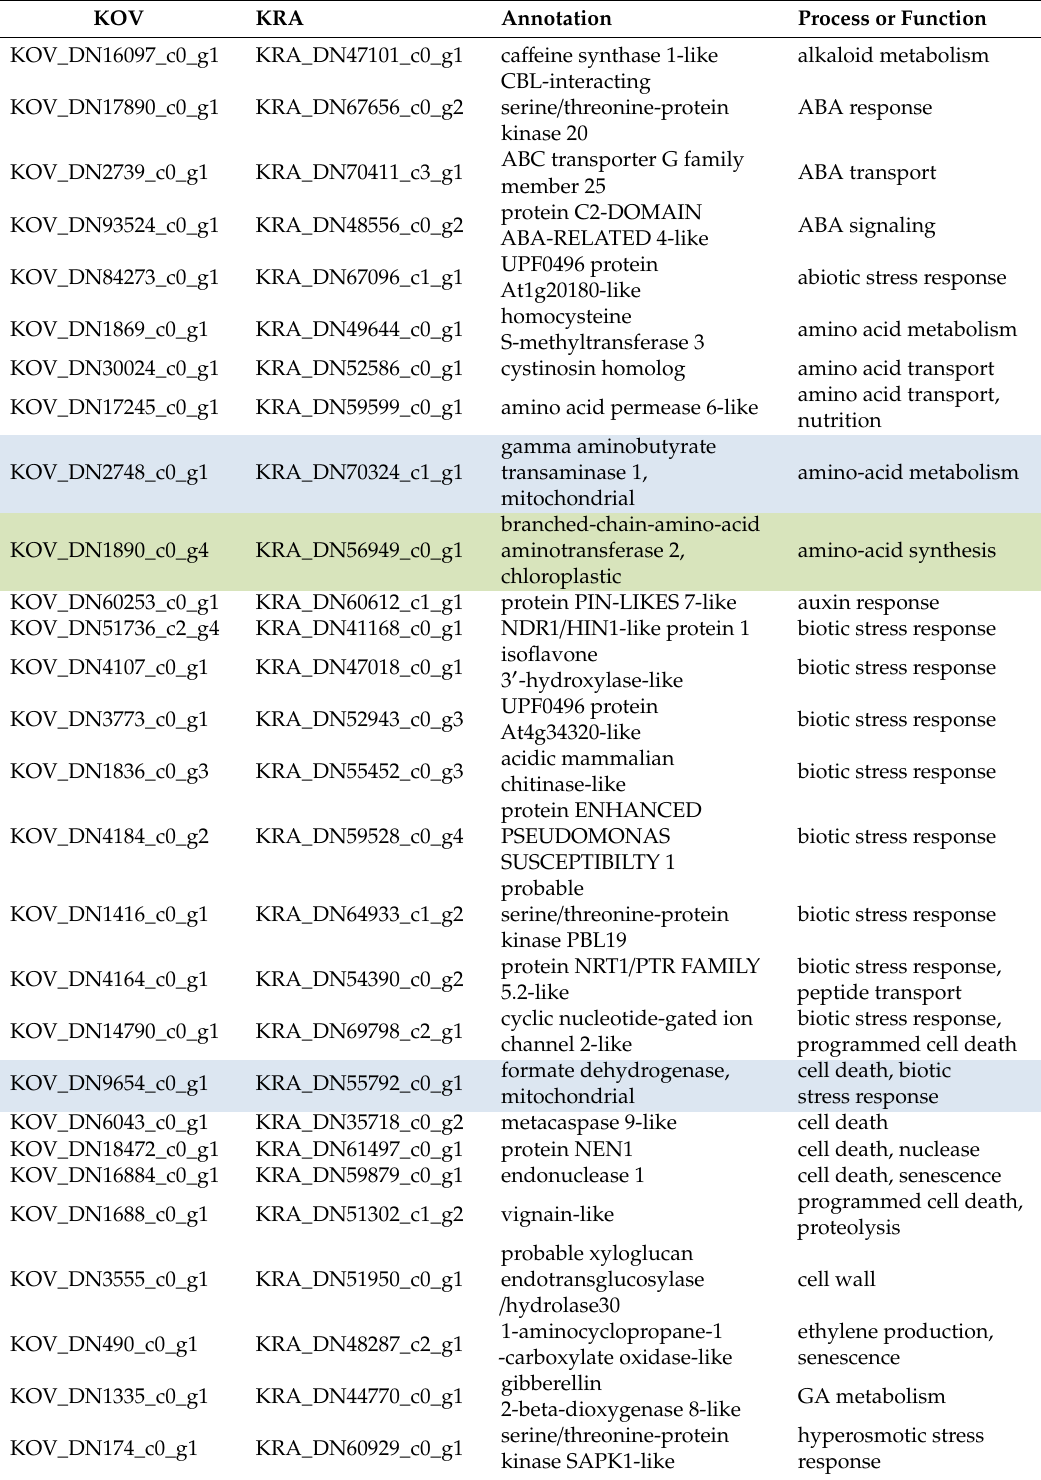
Table 4. Orthologous genes between the KRA and KOV haplotypes upregulated in F flower